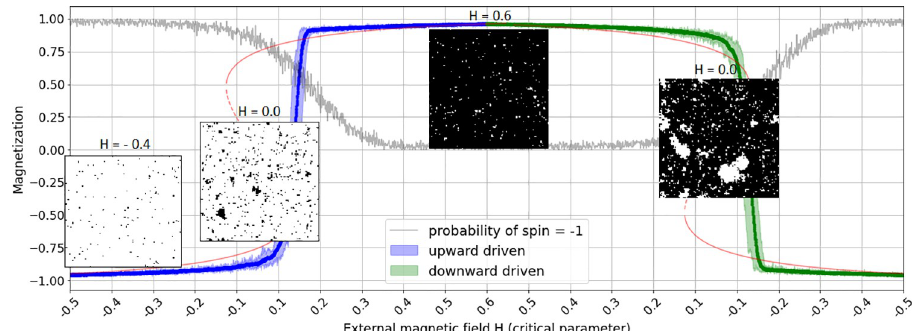
Fig 1. Example simulation of the 2D Ising model. Simulation of the 2D-Ising model with an external magnetic field H taken as critical parameter (see Eq 1), on the x-axis, first increasing (H = -0.5 to 0.6, left half) and then decreasing (H = 0.6 to -0.5, right half). The curve (first blue, then green) shows the overall spin orientation, i.e. the magnetization. Note that its shifts occur at different parameter values in increase and decrease, thus showing hysteresis. The insets visualize snapshots of particle neighborhoods, with insets 2 and 4 taken at the same critical parameter value (H = 0) once in increase and once in decrease, but show distinctly different neighborhood orientations, both though with the characteristic power law distributed cluster sizes. The grey curve indicates the probability of the center patch at (0, 0) being in spin state -1 (white).